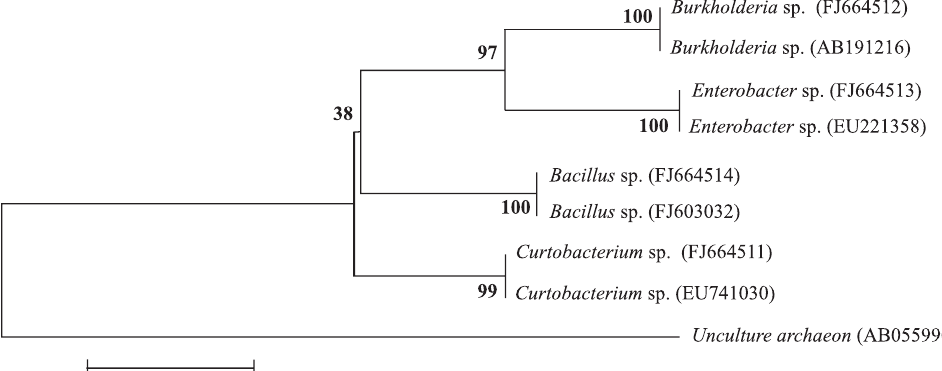
Figure 1. Phylogenetic tree based on 16S rRNA sequences using the Neighbor-Joining method to draw a relationship between rhizobacterial isolates and closely related bacteria listed in GenBank. The numbers on the nodes indicate bootstrap values. The 16S rRNA accession numbers are given within brackets. Bar = 0.1 substitution